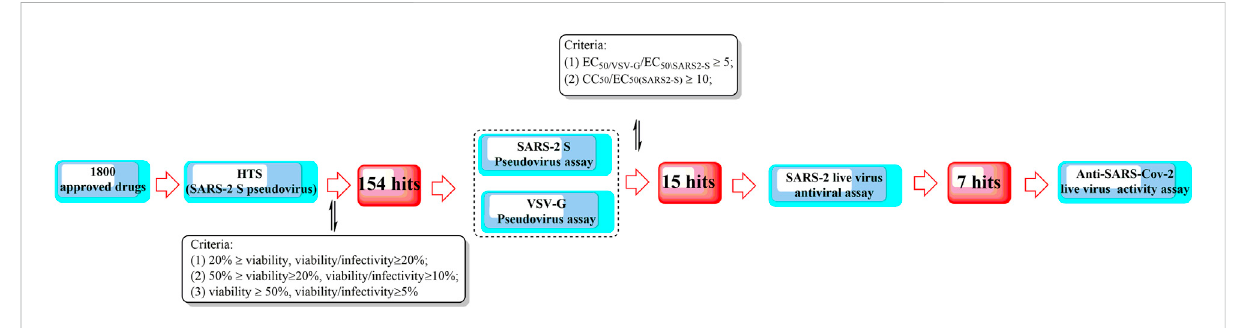
FIGURE 10 A high-throughput screening method for the ef fi cient discovery of SARS-CoV-2 entry inhibitors using a SARS2-S pseudotyped